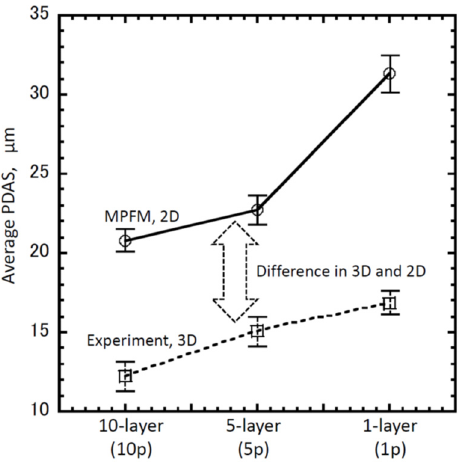
Table 6. Average PDASs from MPFM calculation and experimental measurement.